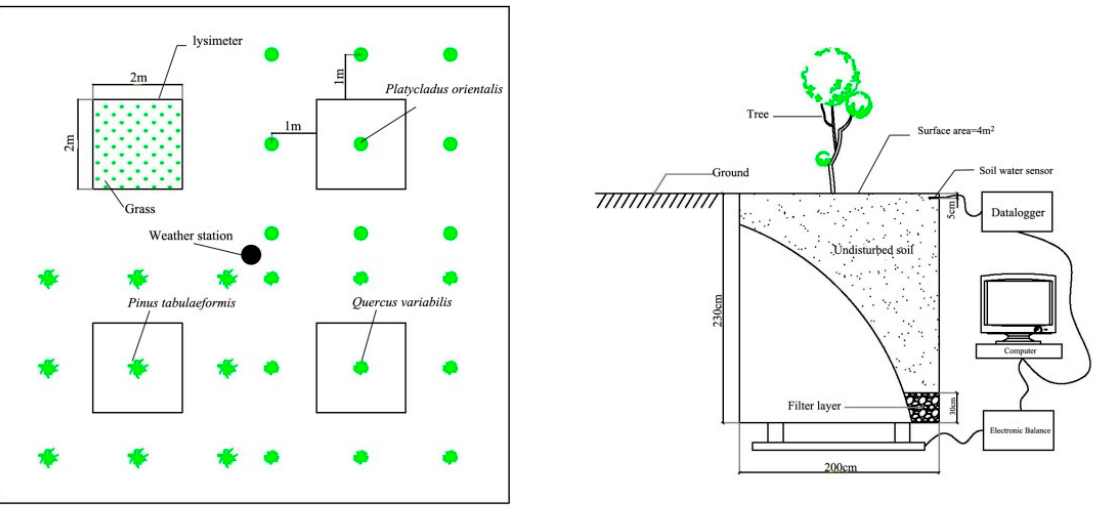
Figure 3. The layout situation and profile of lysimeter station.